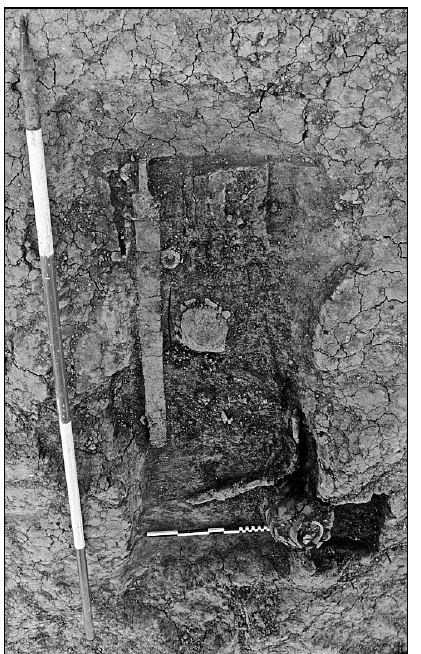
Figure 3 Plans of the grave cuts of the two warrior burials – B20 left and B19 right – showing the location of the bodies and the grave goods (see also Figs 4, 5).